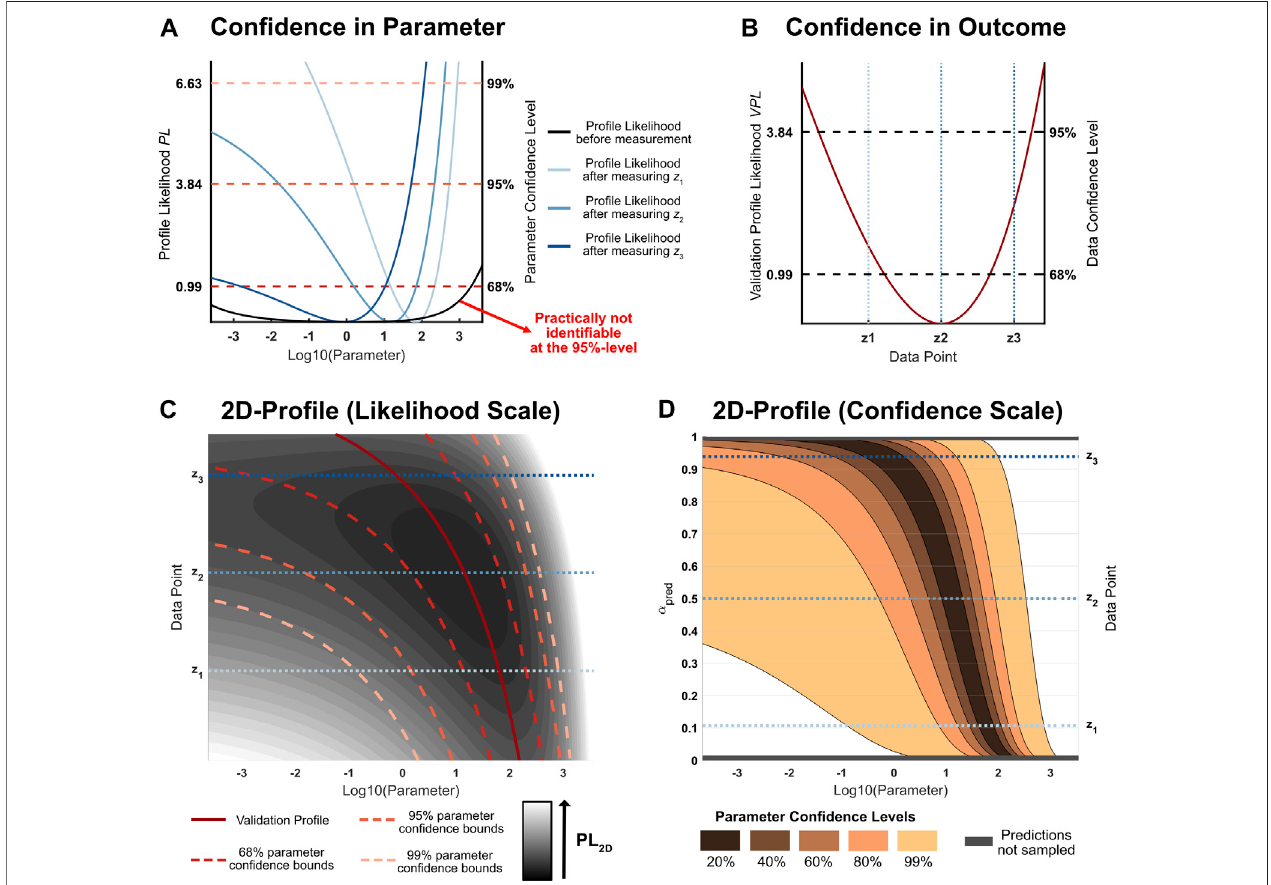
FIGURE 1 | (A) : Likelihood pro fi les of a hypothetical parameter of interest. Different measurement outcomes z 1 , z 2 , z 3 for the same experimental condition lead to differentupdatedparameterpro fi leswhichassessuncertaintyaboutaparameterofinterest. (B) :Validationpro fi leoftheconsideredhypotheticalexperimentalcondition. Thispro fi leassessesthelikelihoodofanewmeasurement:Thesmallerthevalidationpro fi levalue,themorelikelytherespectiveoutcome (C) :2D-Likelihoodpro fi leforthe parameter of interest under some given experimental condition. The vertical axis corresponds to different possible measurement outcomes. If the outcome on the vertical axis would be observed, the pro fi le likelihood after the measurement is given by the corresponding horizontal cross-section through the two-dimensional pro fi le. In this example, lower values of the measurement outcome lead to narrow parameter con fi dence intervals after the measurement. (D) : 2D-Likelihood pro fi le on a con fi dence scale. Intervals of the same size on the y -axis hold equal con fi dence that a measurement will yield a data point in the corresponding interval. The prediction con fi dence levels on the vertical axis illustrate that the sampled two-dimensional likelihood pro fi le covers most of the plausible measurement